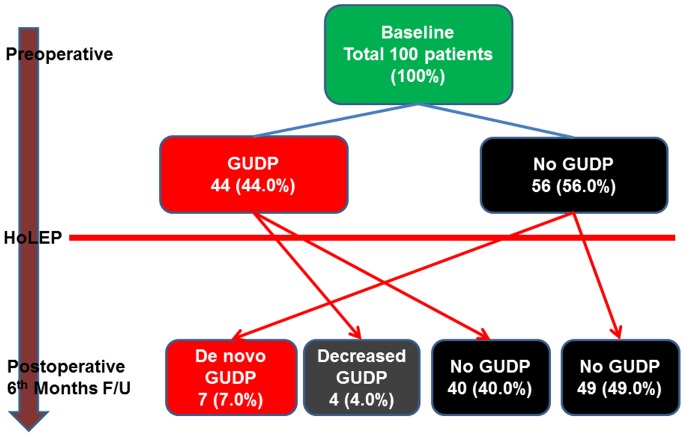
Changes in GUDP from pre to post operation.